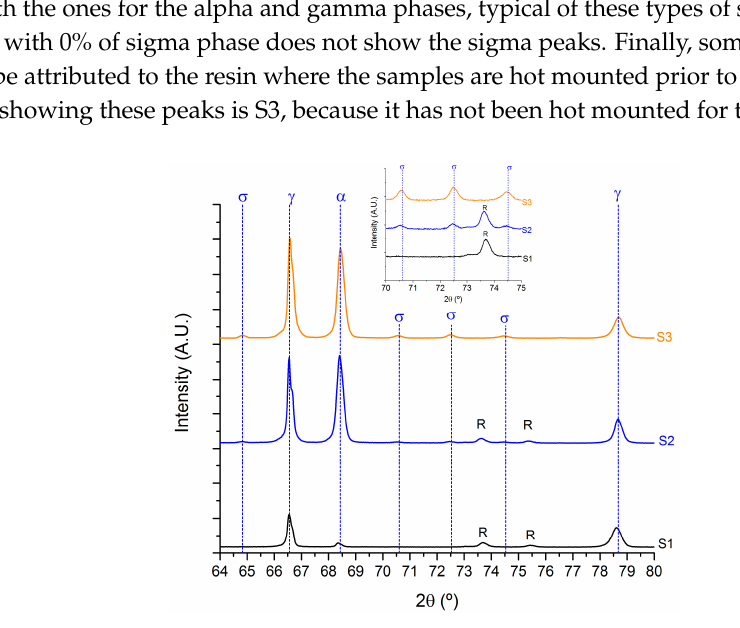
Table 2. Percentage of austenite, ferrite and sigma phases (vol %) as received (S1) and after thermal treatment at a different interval of time (S2 and S3, respectively).